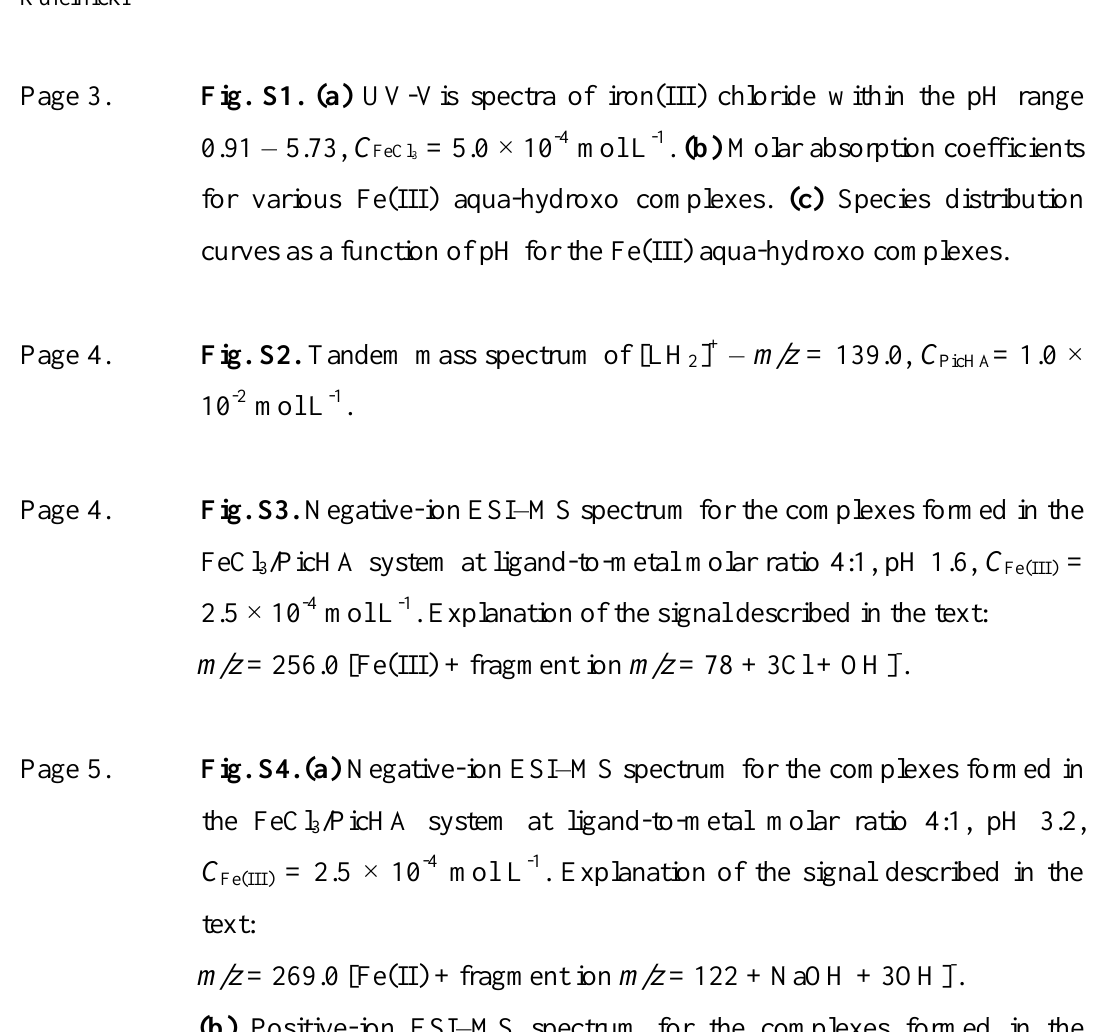
Fig. S1. (a) UV-Vis spectra of iron(III) chloride within the pH range 0.91 – 5.73, C FeCl = 5.0 × 10 -4 mol L -1 . (b) Molar absorption coefficients 3 for various Fe(III) aqua-hydroxo complexes. (c) Species distribution curves as a function of pH for the Fe(III) aqua-hydroxo complexes. Fig. S2. Tandem mass spectrum of [LH ] + – m/z = 139.0, C = 1.0 × 2 PicHA 10 -2 mol L -1 . Fig. S3. Negative-ion ESI–MS spectrum for the complexes formed in the FeCl /PicHA system at ligand-to-metal molar ratio 4:1, pH 1.6, C = 3 Fe(III) 2.5 × 10 -4 mol L -1 . Explanation of the signal described in the text: m/z = 256.0 [Fe(III) + fragment ion m/z = 78 + 3Cl + OH] - . Fig. S4. (a) Negative-ion ESI–MS spectrum for the complexes formed in the FeCl /PicHA system at ligand-to-metal molar ratio 4:1, pH 3.2, 3 C = 2.5 × 10 -4 mol L -1 . Explanation of the signal described in the Fe(III) text: m/z = 269.0 [Fe(II) + fragment ion m/z = 122 + NaOH + 3OH] - . (b) Positive-ion ESI–MS spectrum for the complexes formed in the FeCl /PicHA system at ligand-to-metal molar ratio 4:1, pH 3.2, C = 3 Fe(III) 2.5 10 -4 mol L -1 . Explanation of the signals described in the text: m/z = 197.0 [Fe(II) + fragment ion m/z = 106 + Cl] + m/z = 255.0 [Fe(II) + fragment ion m/z = 106 + NaCl + Cl] +